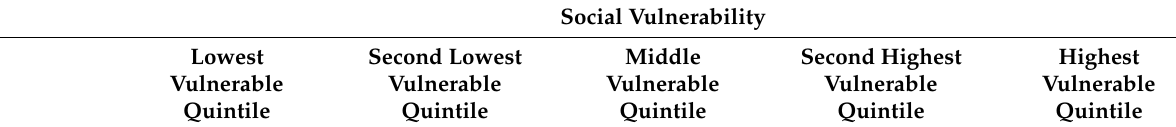
Table 2. Neighborhood socio-demographic characteristics by level of social